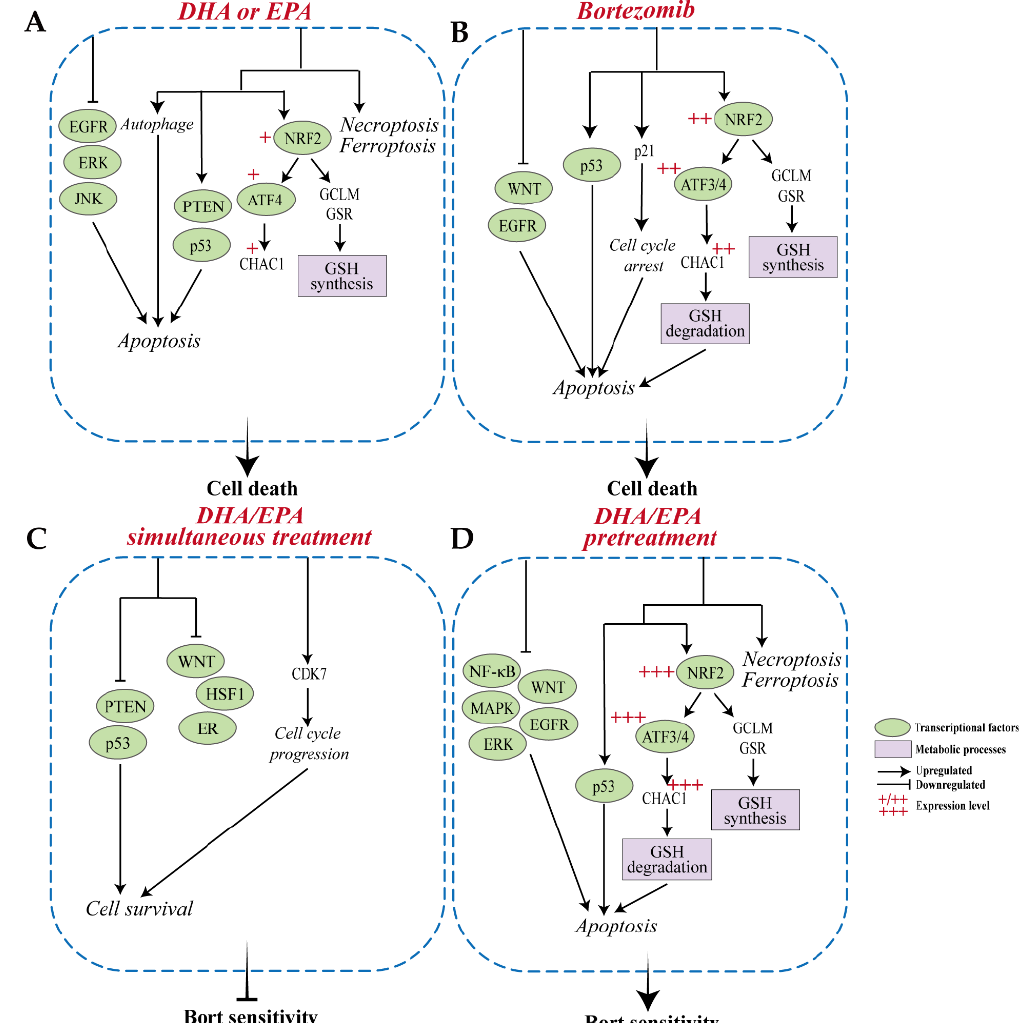
Figure 7. Possible mechanism underlying the opposite effects of the different treatment schedules with DHA/EPA on bortezomib chemosensitivity in MM cells. ( A ) DHA or EPA may induce MM cell death through activating PTEN and p53 signaling pathways, p62-mediated autophagy, ferroptosis, and necroptosis, and inhibiting ERK, JNK, and EGFR signaling pathways. ( B ) Bortezomib-induced MM cell death may include blocking pro-survival pathways of WNT and EGFR and activating pathways of p53 and NRF2-ATF3/4-CHAC1 and p21-mediated cell cycle arrest. ( C ) Simultaneous treatment with bortezomib and DHA or EPA may decrease bortezomib chemosensitivity in MM cells through inhibiting PTEN and p53 pathways and activating CDK7-mediated cell cycle progression. ( D ) Pretreatment with DHA or EPA prior to bortezomib increase bortezomib sensitivity possibly through activating p53 and NRF2-ATF3/4-CHAC1 pathways, ferroptosis and necroptosis and inhibiting pathways of WNT, NF- κ B, MAPK, ERK, and EGFR in MM cells.